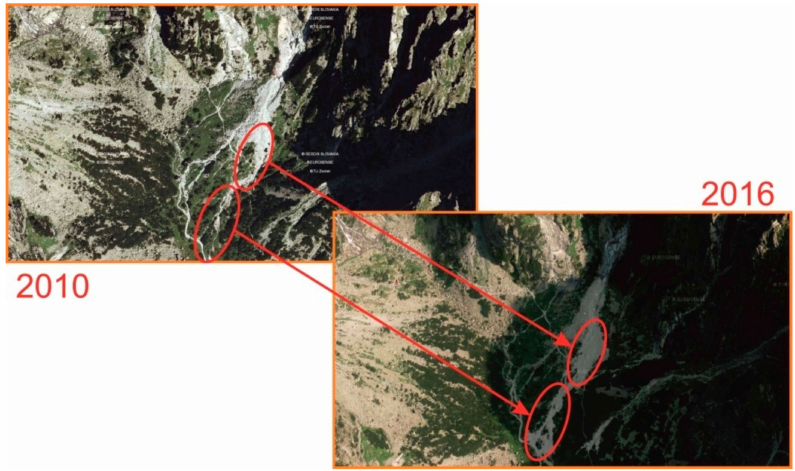
Figure 2. Visible changes in the monitored talus cone in the Little Cold Valley, High Tatras, Slovakia. Aerial photos from 2010 and